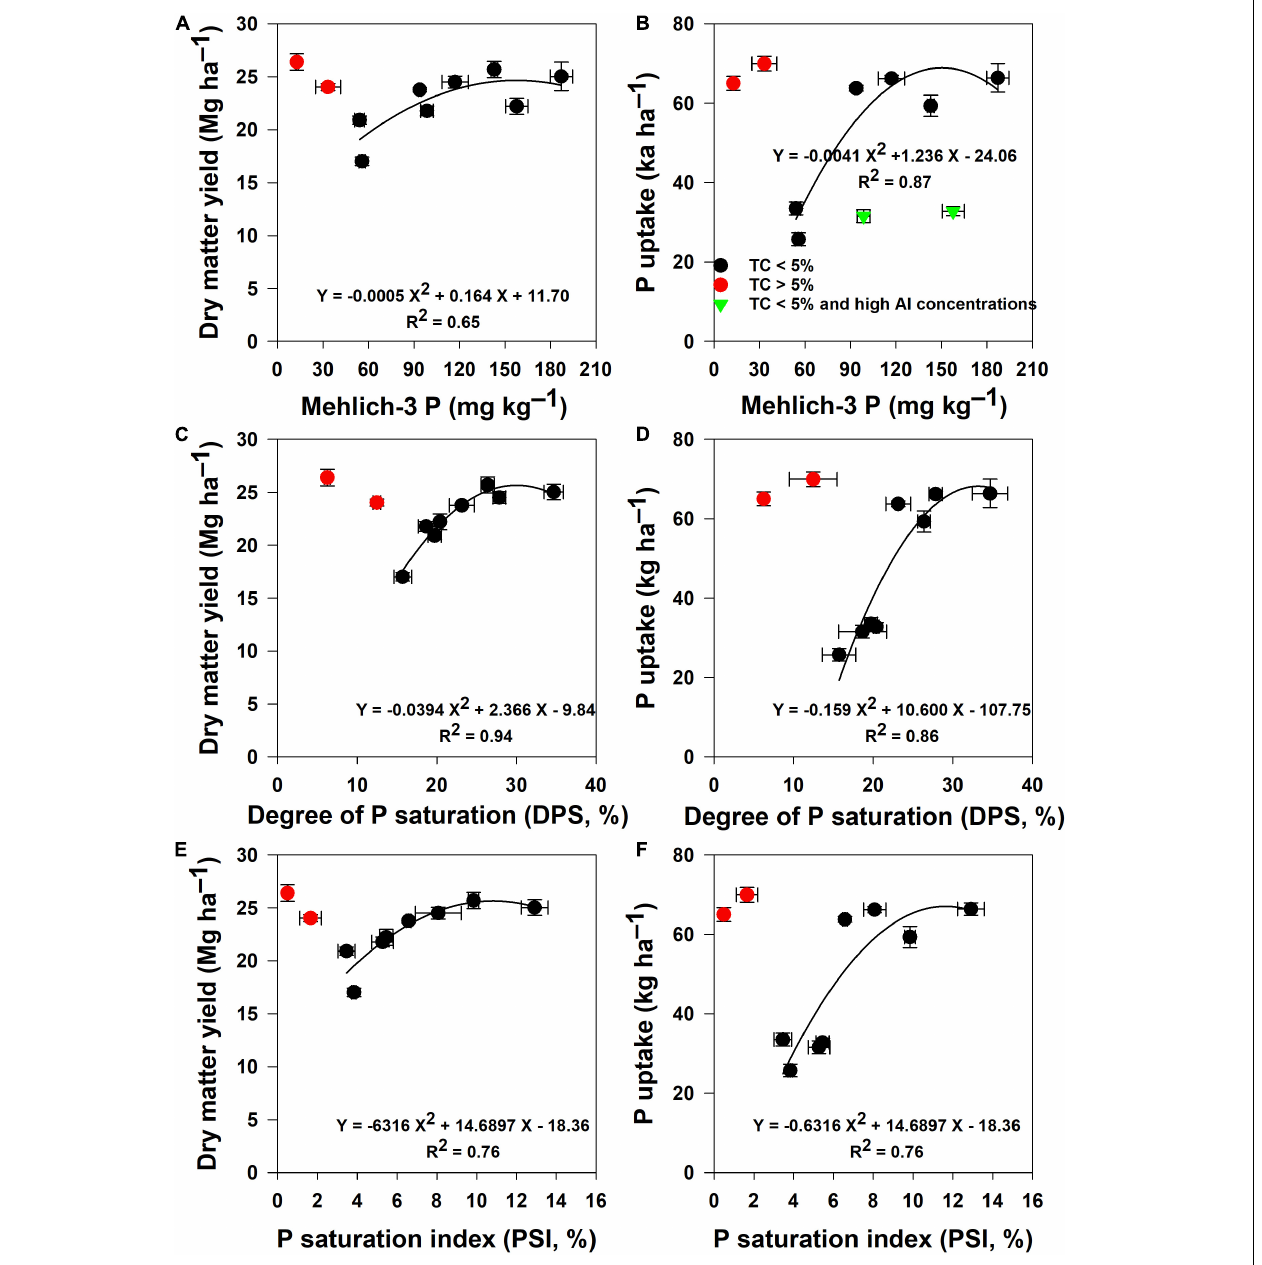
FIGURE 9 | Mehlich-3 P (A,B) ; Degree of P saturation (C,D) ; P saturation index (E,F) vs. Dry matter yield and P uptake at harvest with application of starter P rates and dairy manure across 11 sites in the Fraser Valley, BC. Dairy manure was applied at 6-leaf stage. Error bars represent standard deviations of the